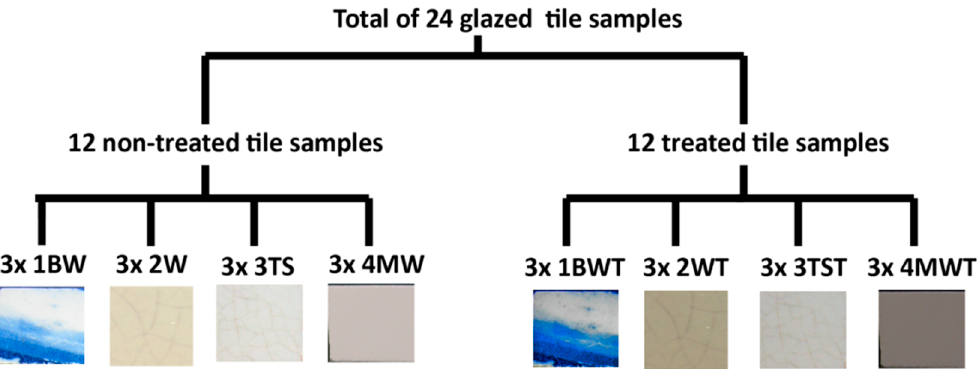
Figure 1. Scheme with experimental design with the number of replicates of non-treated (1BW, 2W, 3TS and 4MW) and TiO 2 -treated (1BWT, 2WT, 3TST and 4MWT)